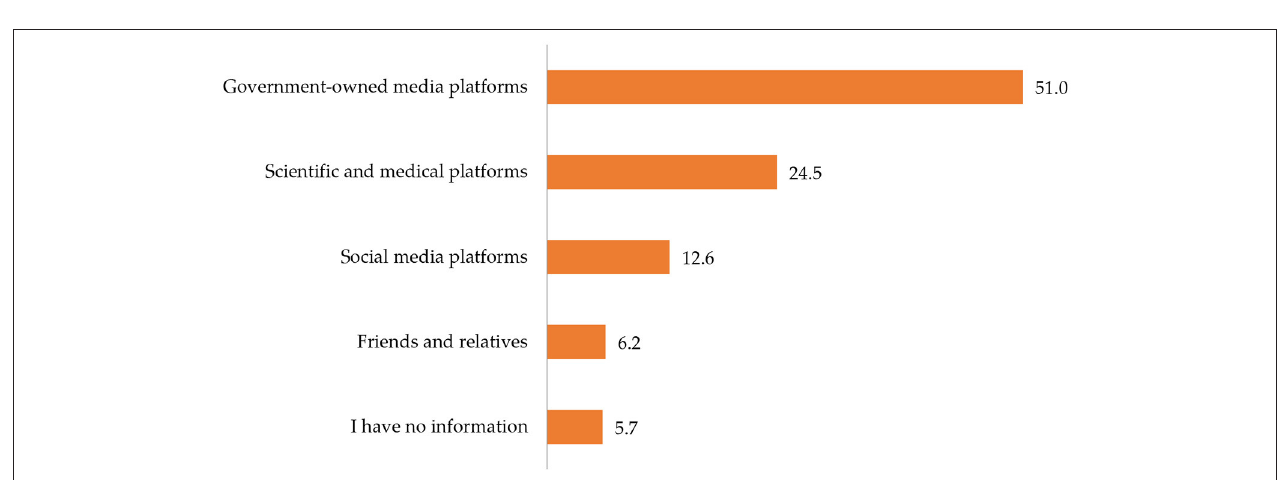
FIGURE 2 | Source of information about COVID-19 vaccination.